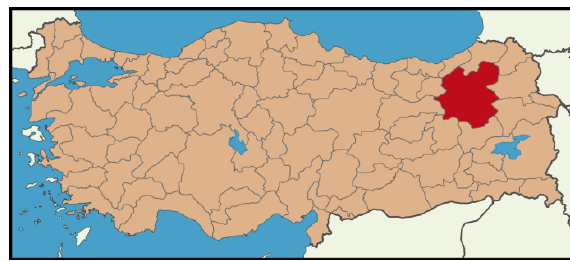
Figure 1. Position of the City of Erzurum inside